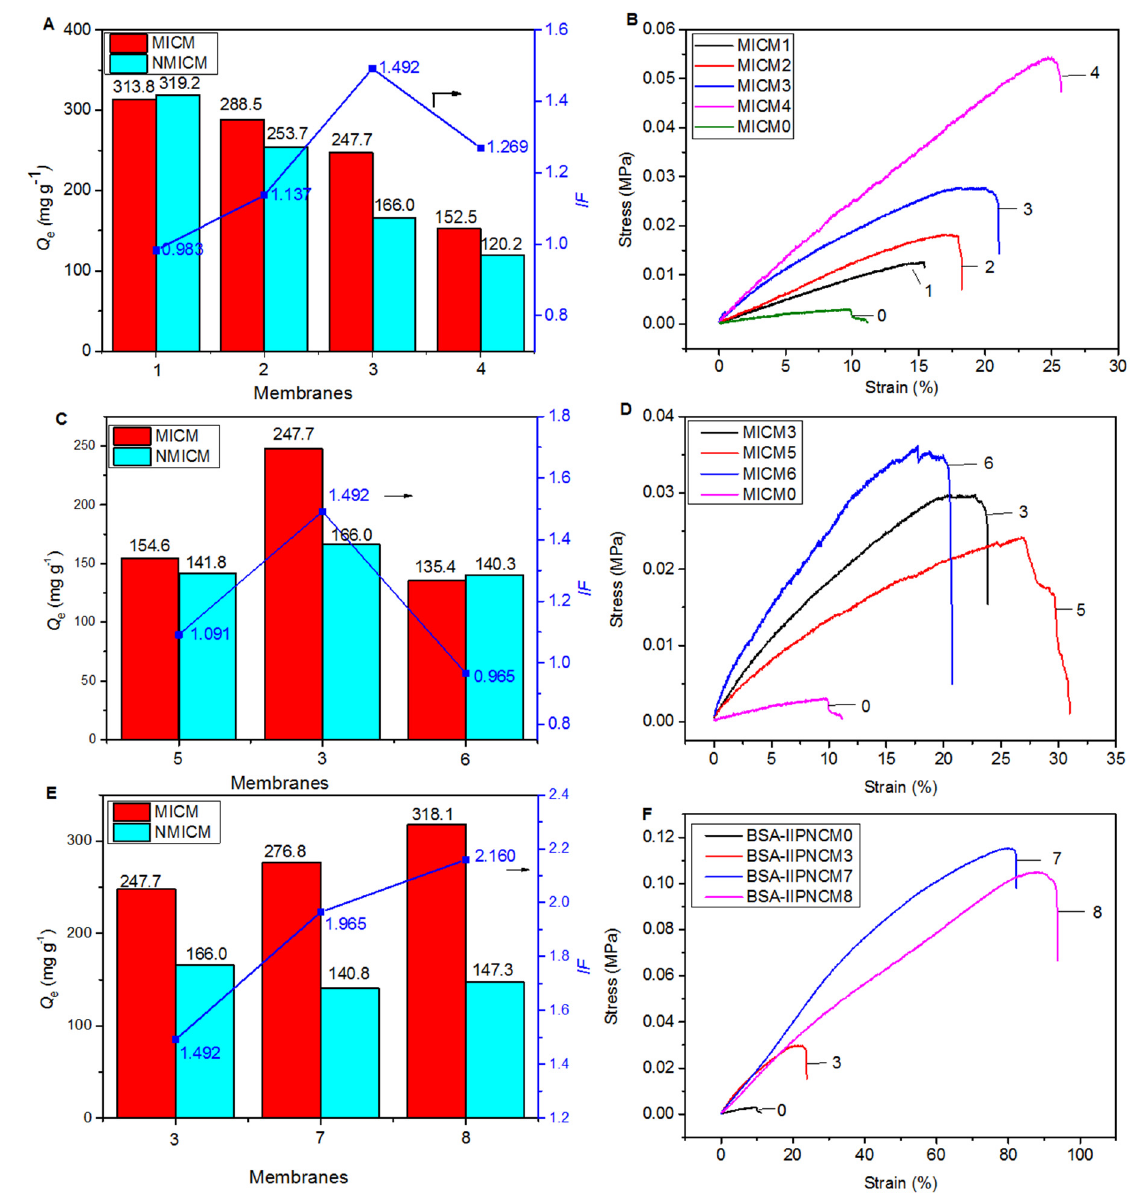
Figure 5. The effects of the amount of SA, cross-linker, [VAMIM]Cl and MBA on the adsorption ( A , C , E ) and mechanical ( B , D , F ) properties of various MICM and NMICM.